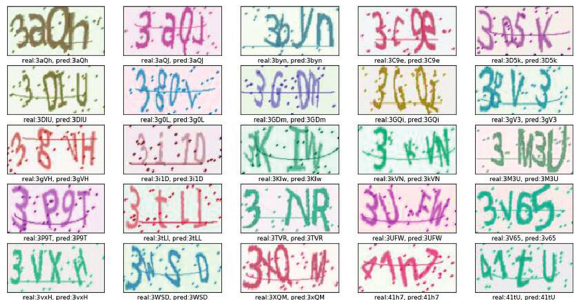
Figure 12: Recognition results on random generated CAPTCHA.